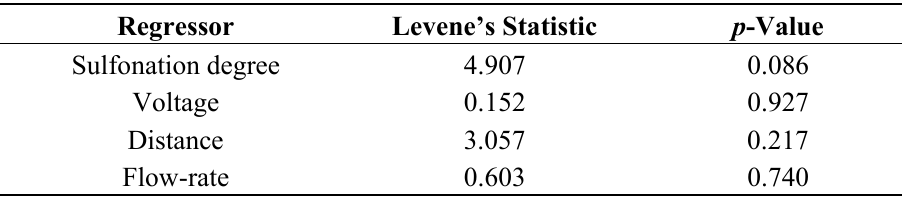
Table 7. Summary of the Levene’s test for the analysis of the homoscedasticity conditions of the residuals of the different levels of the model